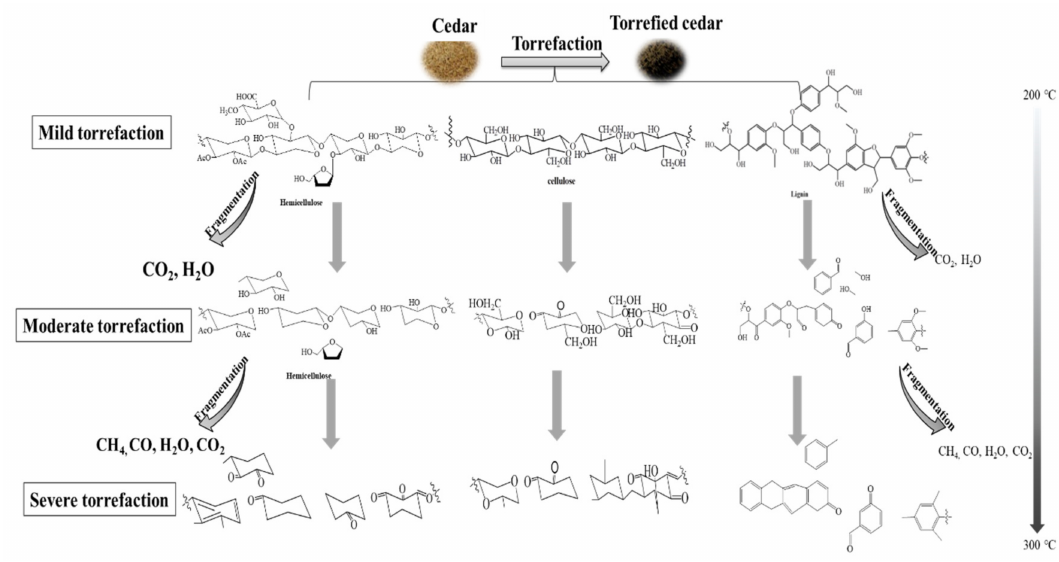
Figure 5. Structural evolution of cedar